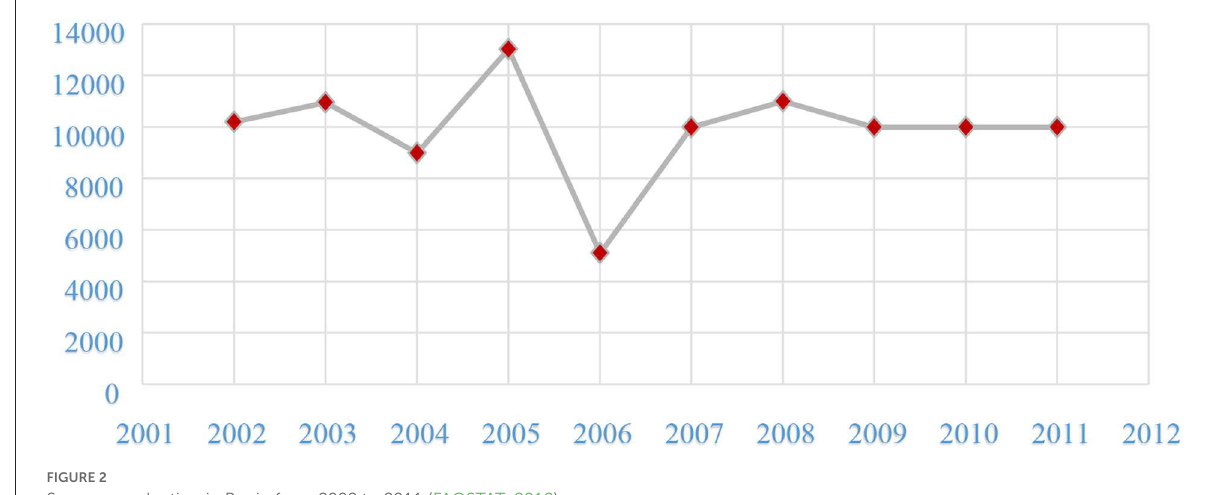
FIGURE2 Sesame production in Benin from 2002 to 2011 (FAOSTAT, 2012).